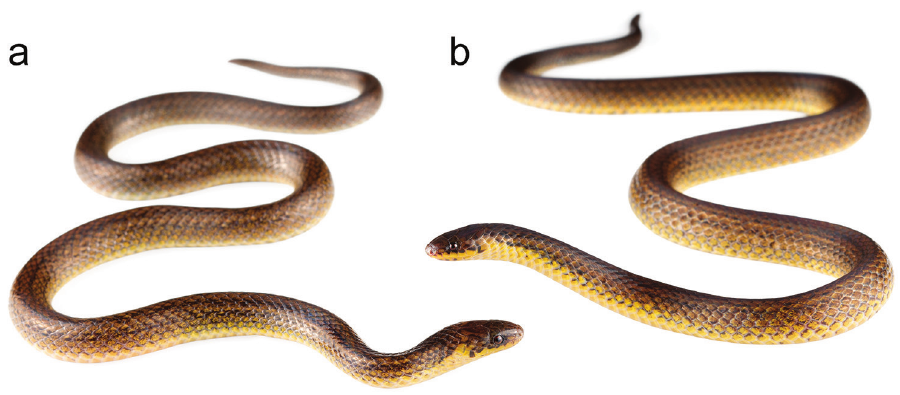
Figure 5. Adult male holotype MZUTI 4330 ( a ) and adult male paratopotype ( b ) of Atractus cerberus MZUTI